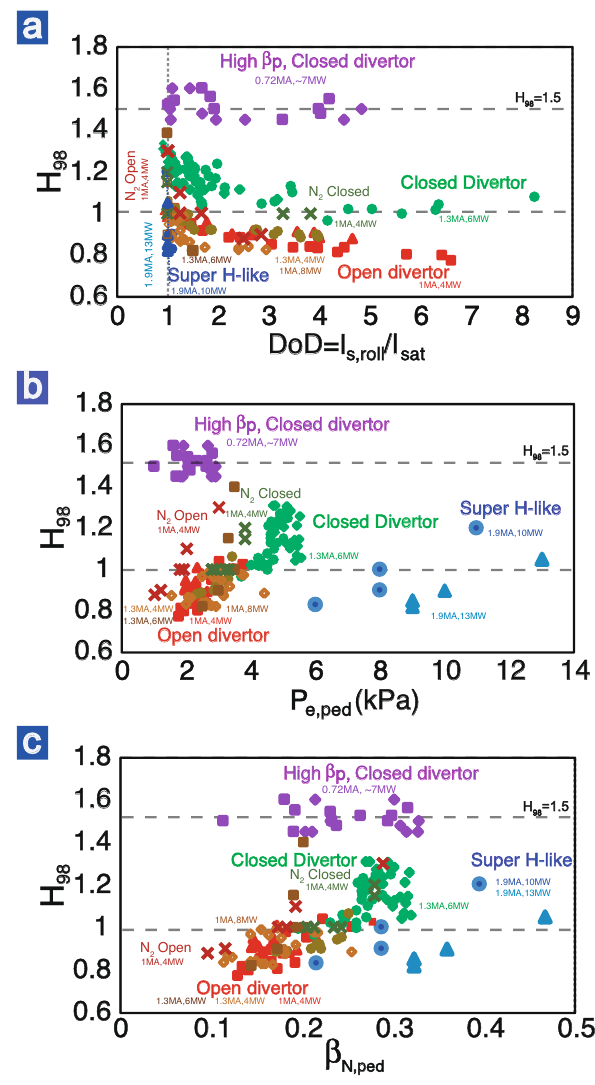
Fig. 4 The global energy con fi nement quality under different detached conditions. The H 98 versus degree of detachment ( a ), pedestal pressure ( b ), and pedestal β N,ped (c) across several plasma scenarios. The scenarios compared are open divertor standard H-mode (red), closed divertor standard H-mode (green), super H-like (blue), and high- β p (purple) plasmas. The power and plasma current are also labeled. β N,ped = β ped /( I p / aB B T ) takes different plasma current and T into account for a better comparison of the pedestal pressure. The plasma shapes for open and closed geometries can be found in refs. 43,45 . The purple-diamond data in high- β p are taken from Fig. 1 and purple-square data are from a similar